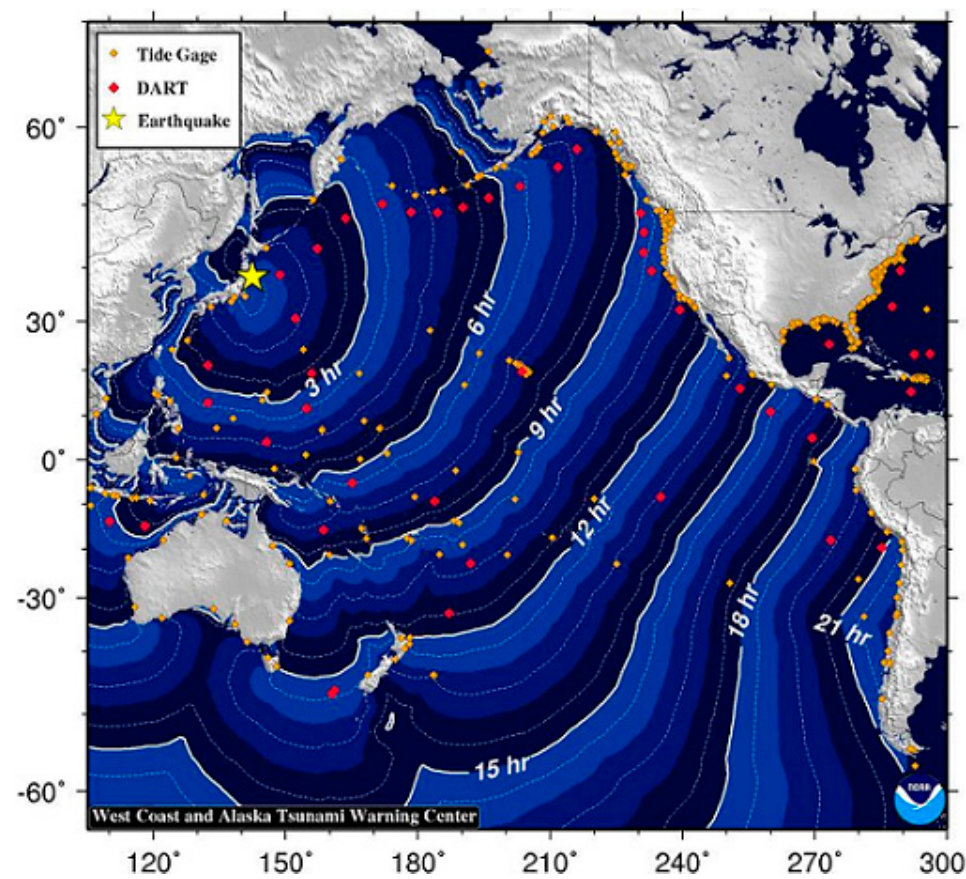
Figure 1. Travel time map of the 2011 Tohoku tsunami. The spatial distribution of tide gauge (orange point), DART (red point), and location of the epicenter (yellow star) are shown in the figure [17].